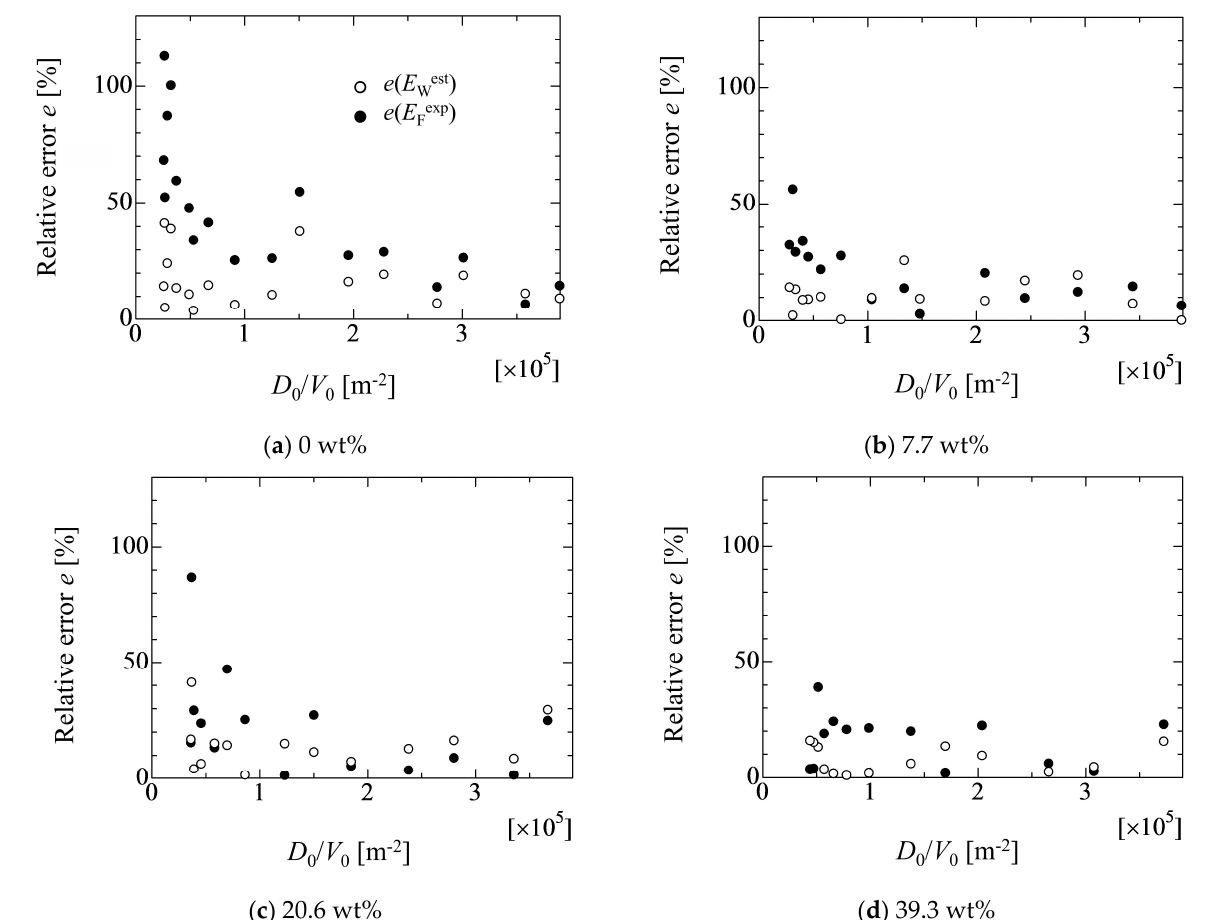
Figure 14. Relative errors of e ( E West ) and e ( E Fexp ) in each liquid case. The values of e ( E West ) and e ( E Fexp ) are calculated by Equation (7) as 100 × |( E W − E West )/ E W | and 100 × |( E W − E Wexp )/ E W |, respectively. E W , E Fexp and E West are estimated by Equations (1), (4) and (6),